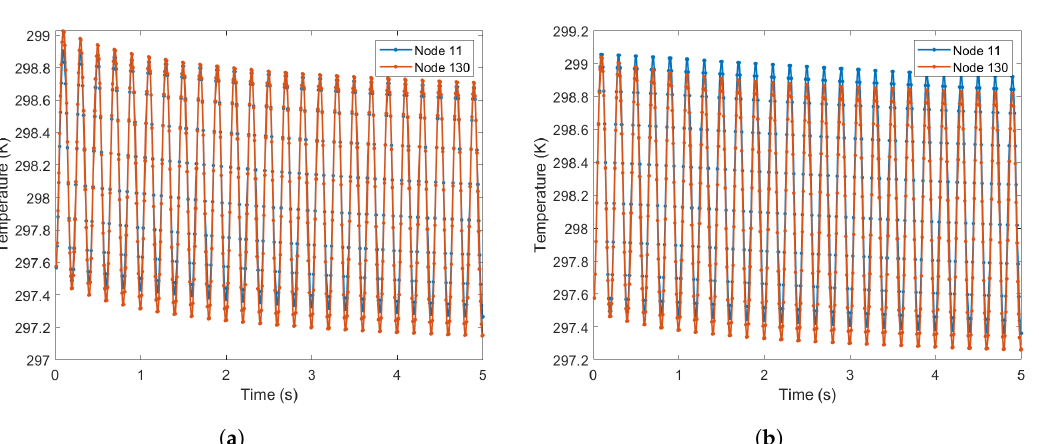
Figure 15. Temperature variation with time in the specimen with f = 5 Hz. ( a ) k x = 12,000 W/m · K and E x = 10 GPa. ( b ) k x = 12,000 W/m · K and E x = 300 GPa.